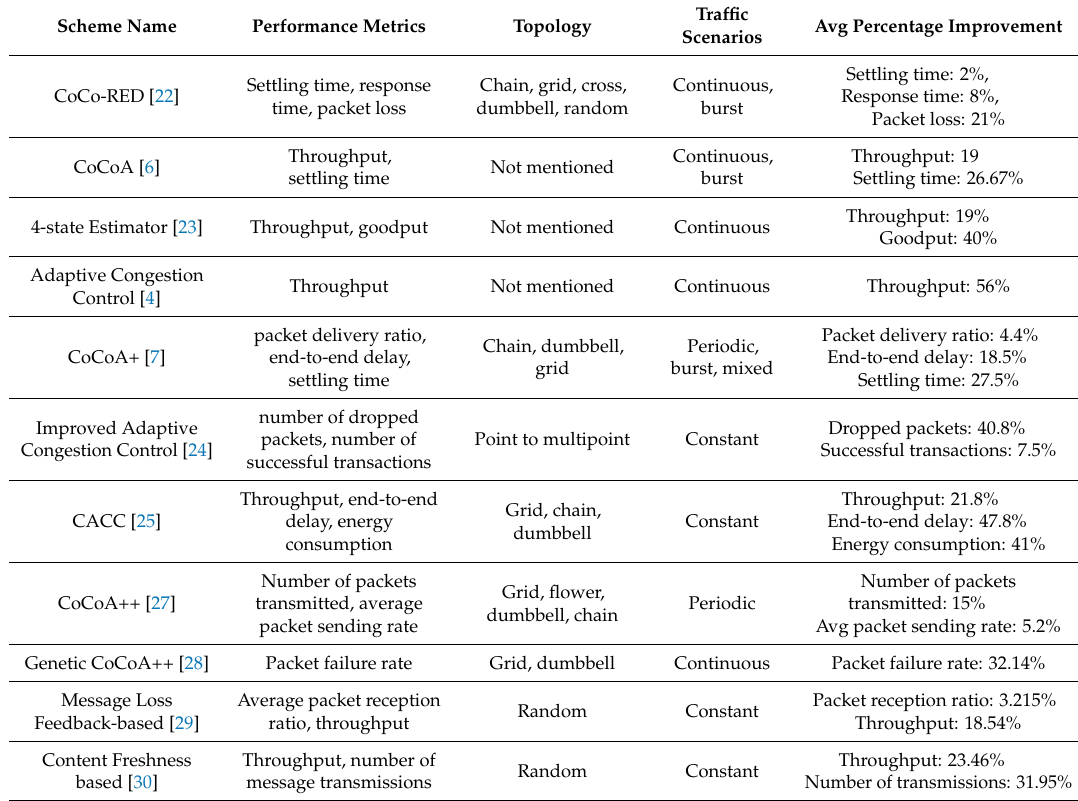
Table 3. Quantitative Analysis of Enhanced Congestion Control